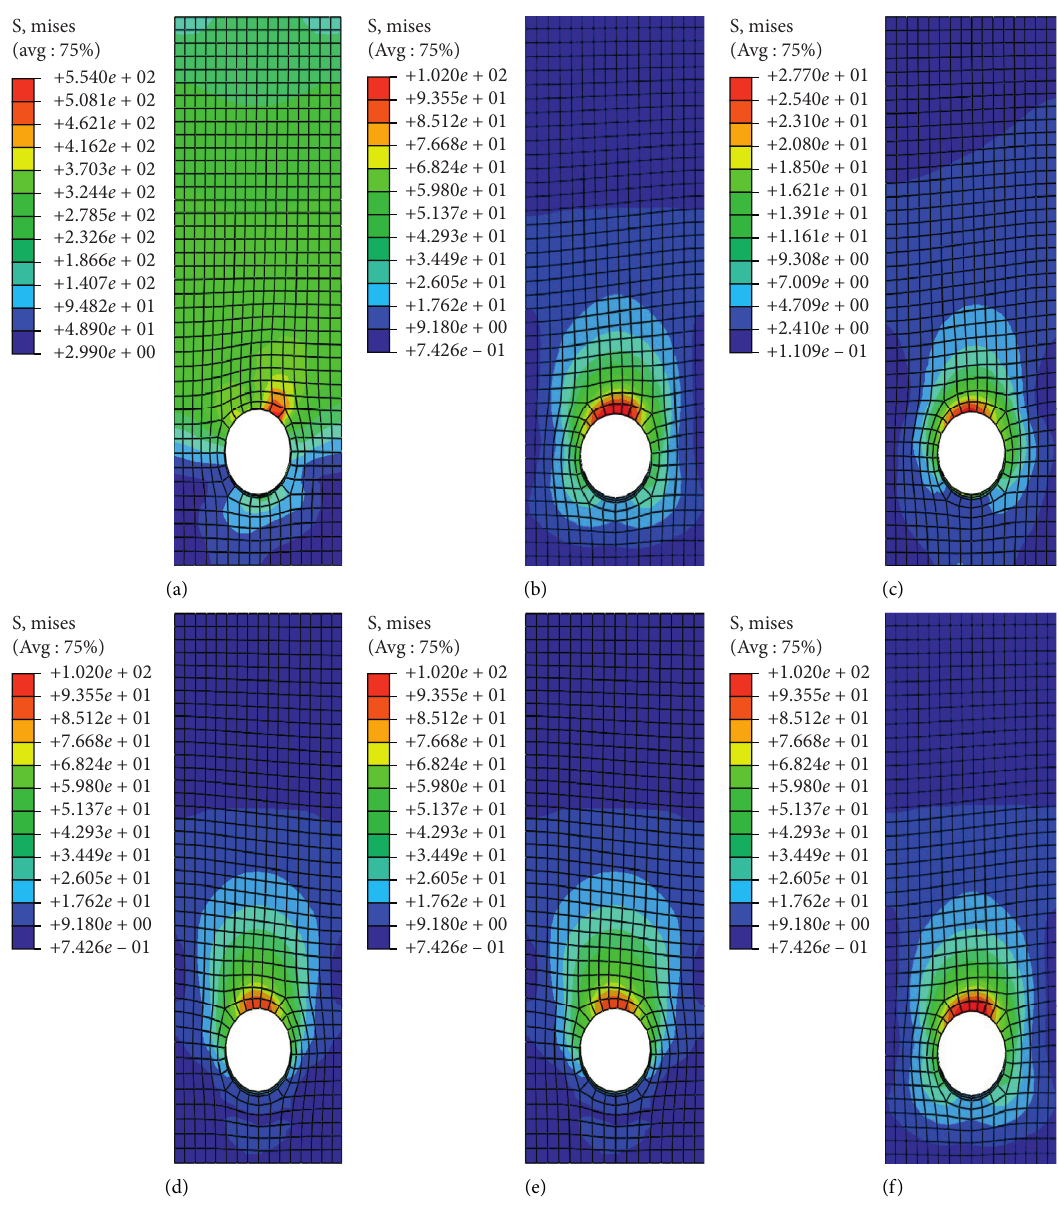
Figure 3: Results of experiment numerical simulation: (a) thickness � 0, (b) thickness � 0.1, (c) thickness � 0.4, (d) thickness � 0.7, (e) thickness � 0.9, and (f) thickness �